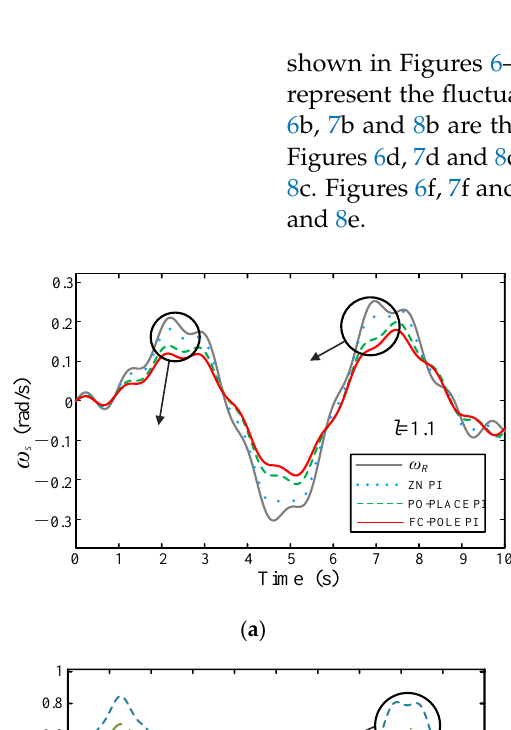
represent the fluctuation trend of system rotation frequency, torque and angle. Figures 6b, 7b and 8b are the local enlarged image of the marked part in Figures 6a, 7a and 8a. Figures 6d, 7d and 8d are the local enlarged image of the marked part in Figures 6c, 7c and 8c. Figures 6f, 7f and 8f are the local enlarged image of the marked part in Figures 6e, 7e and 8e.